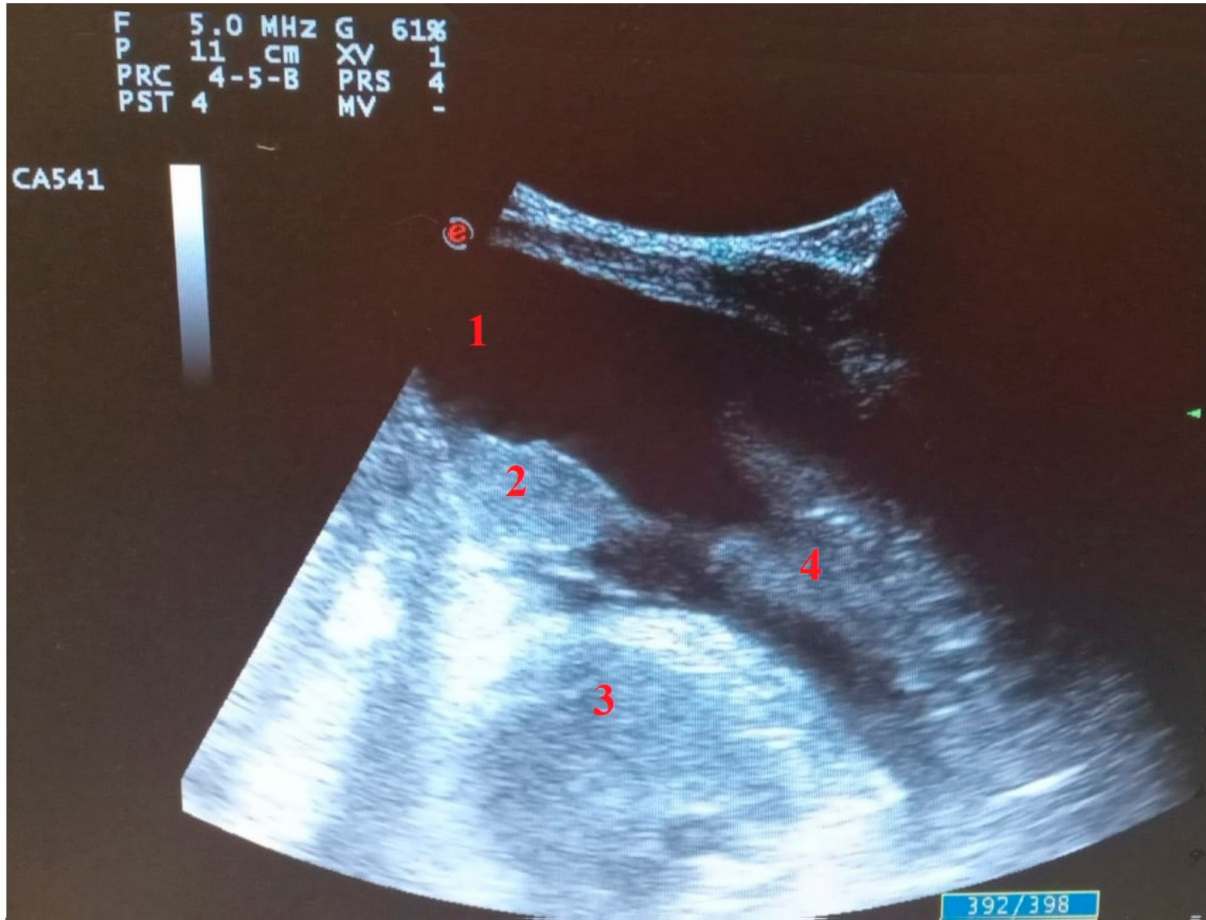
Figure 5. Longitudinal scan with convex probe in COVID-19 patient on mechanical ventilation with bacterial superinfection: (1) pleural effusion, (2) parenchymal consolidation without air bronchogram, (3) heart, (4) parenchymal consolidation with air